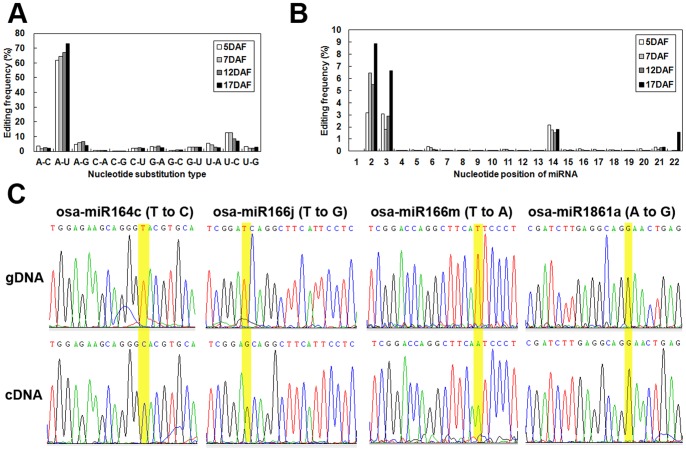
miRNA editing analysis.(A) Summary of the nucleotide substitution types observed in each library. (B) Summary of nucleotide substitution positions among miRNAs. (C) Validation of the editing sites inferred from deep sequencing via Sanger sequencing. Sequencing chromatogram traces from four miRNA sequences are shown. The edited positions are highlighted with yellow shading. The top trace is genomic DNA (gDNA), and the bottom trace is cDNA.